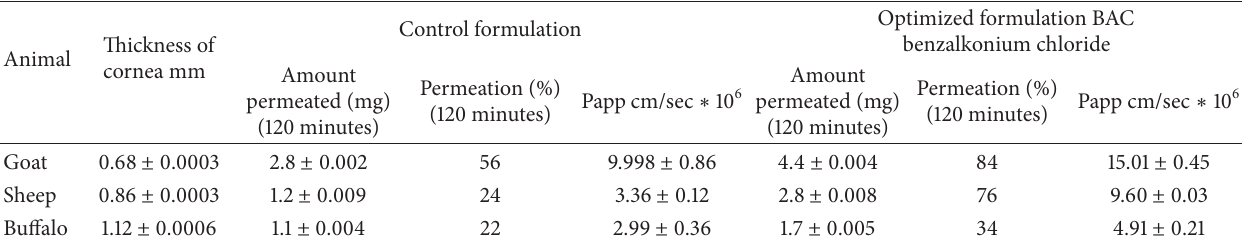
Figure 2: (a) Red blood cell and (b) red blood cell with optimized formulation aceclofenac eye drops containing HPMC. Table 3: In vitro relative permeation characteristics of aceclofenac from control and optimized formulation through excised goat, sheep, and buffalo